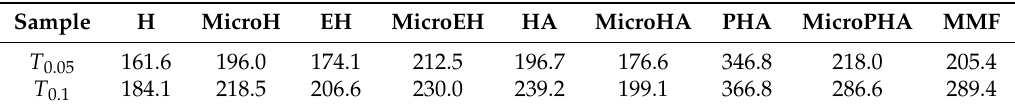
Figure 6. TGA curves comparison of various PCMs and Micro/NanoPCMs: ( a 0 ) n -hexadecane; ( b 0 ) ethyl hexadecanoate; ( c 0 ) hexadecyl acrylate; ( d 0 ) poly(hexadecyl acrylate); ( a 1 ) MicroH; ( b 1 ) MicroEH, ( c 1 ) MicroHA; ( d 1 ) MicroPHA; and ( e 1 ) MMF shell. Table 2. Thermal stability comparison of various PCMs and Micro/NanoPCMs.